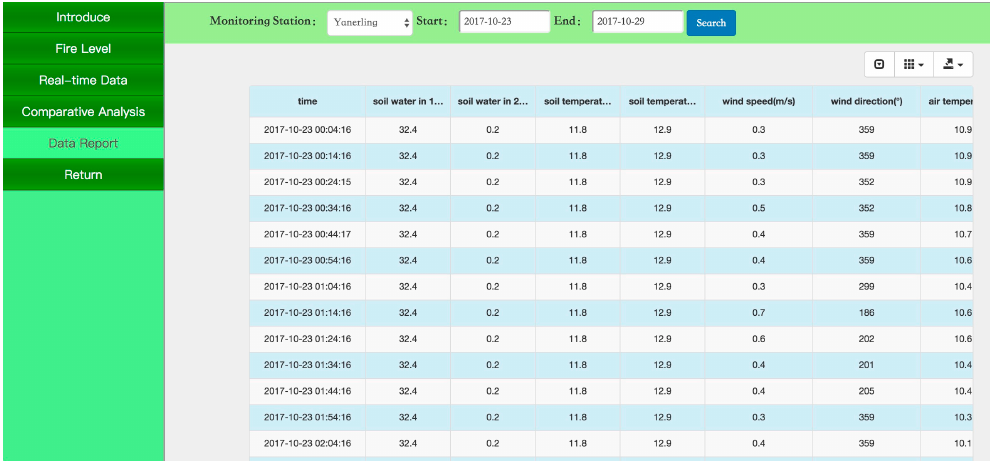
Figure 7. Monitoring data reports of the forest microclimate